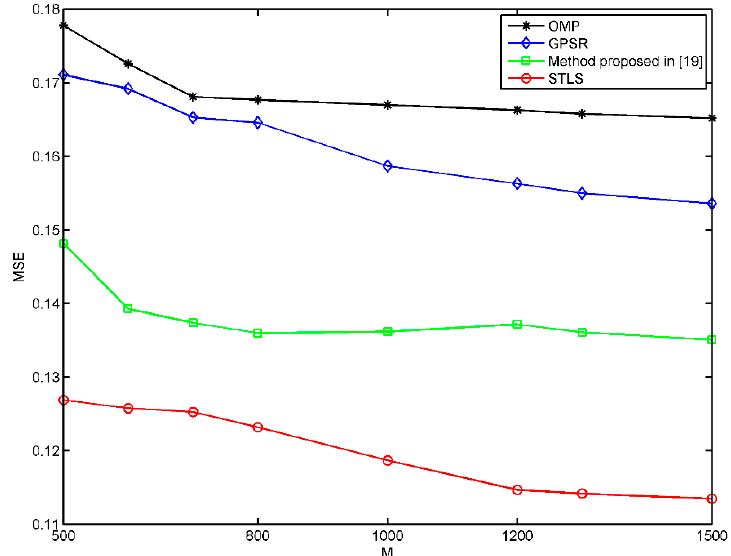
Figure 7. MSE of the reconstructed quantum ghost imaging with OMP, GPSR, Method proposed in [19] and STLS with different sampling numbers.